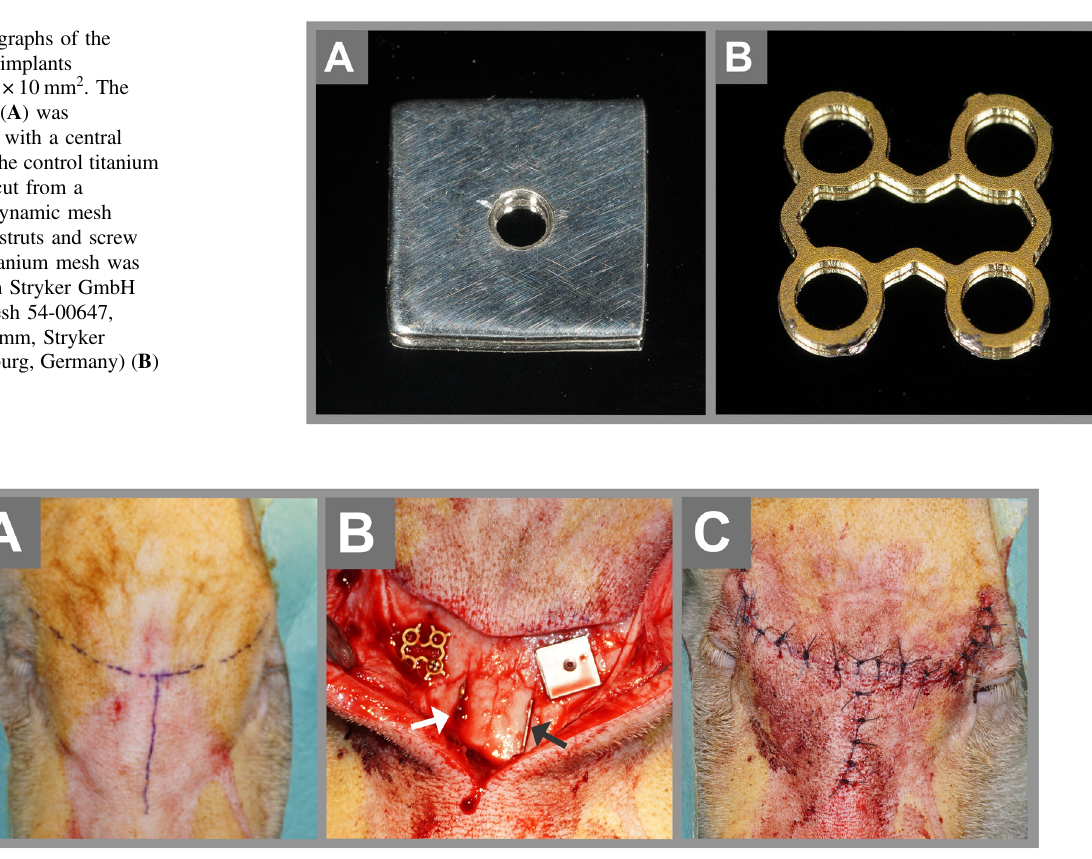
Fig. 2 Photographs of the surgical procedure: the tip of the nose is located at the lower edge of the pictures. An arch incision was com- bined with a nasal extension to expose the frontal and nasal bones ( A ). A full-thickness incision was performed through the skin, sub- cutaneous tissue, and periosteum using a scalpel no. 15. By blunt dissection the periosteum was elevated and the bone exposed. The subperiosteal implants were adjusted on the surface of the frontal bone and fi xated with one screw each (self-cutting titanium screw, diameter